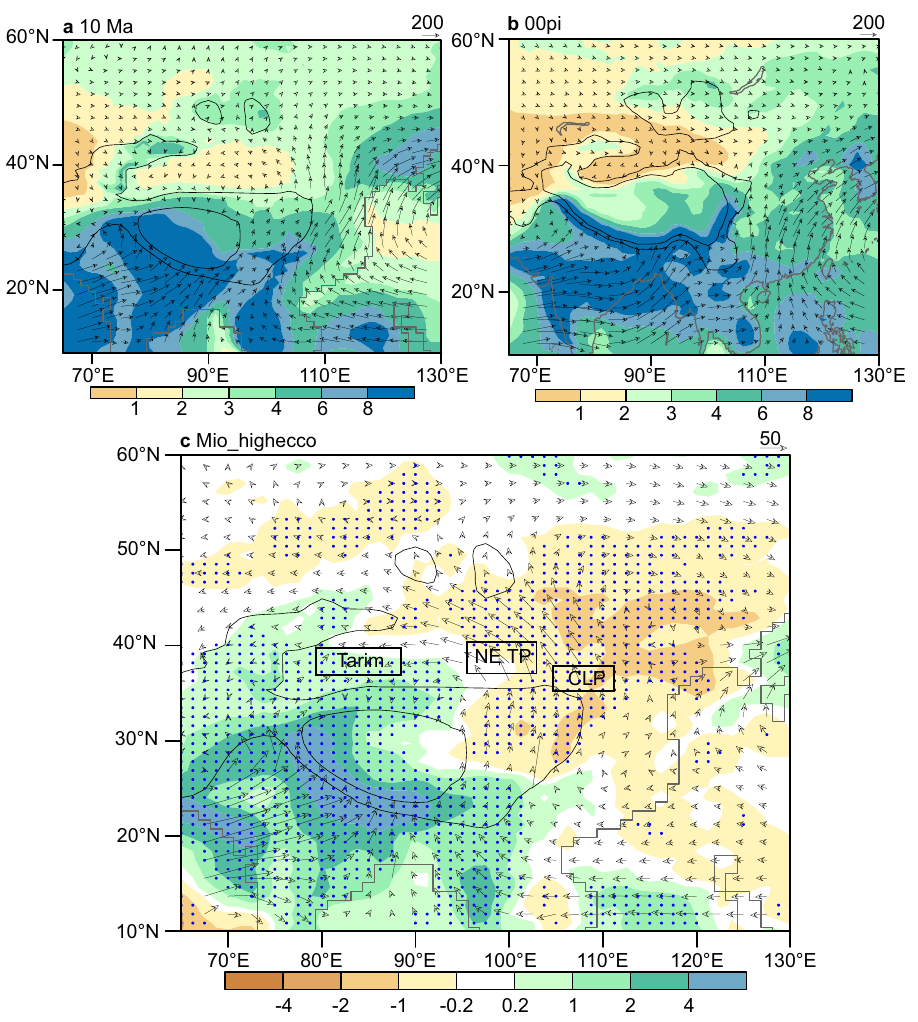
Fig. 3 Simulated summer (JJA) precipitation (shaded, mm day − 1 ) and water vapor transport integrated from the surface to 700 hPa (vector, units: kg m − 1 s − 1 ). JJA June, July and August. a Results using 10 Ma background boundary conditions and orbital parameters for 1950. b Results using pre- industrial background boundaries and orbital parameters for 1950. c Precipitation and water vapor transport differences when increasing eccentricity from 0.01672 (year 1950) to 0.05. The difference is calculated by subtracting the high eccentricity results from the low eccentricity results. Green (yellow) color indicates more precipitation under lower (higher) eccentricity. Topography levels equal to 1500 m and 3000 m are highlighted with gray contours. The three black rectangles in c represent the rough locations of the Tarim Basin, Northeastern (NE) Tibetan Plateau (TP) and the Chinese Loess Plateau (CLP). Dotted regions indicate differences that are signi fi cant at the 90% con fi dence